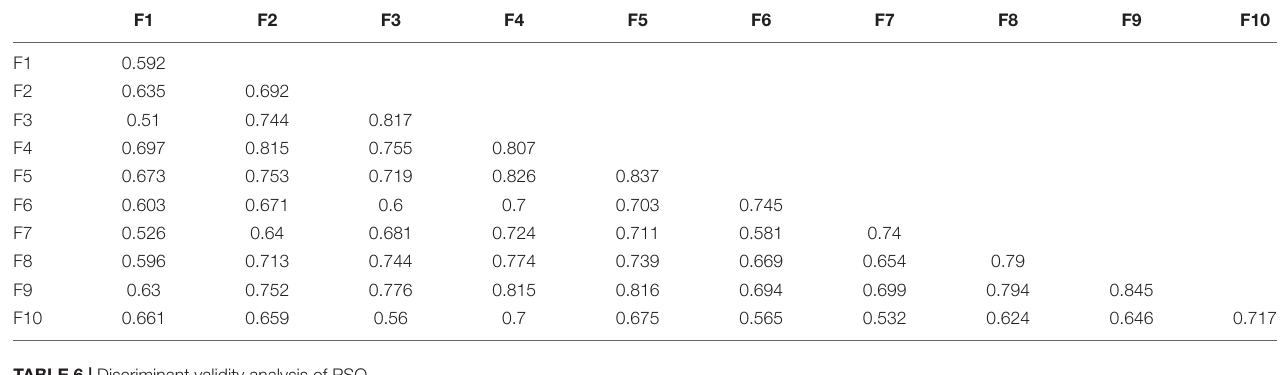
TABLE 6 | Discriminant validity analysis of PSQ.